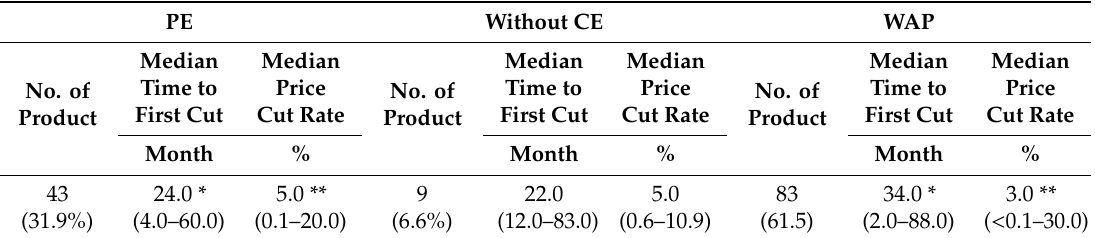
Table 2. Time elapsed until the first price cut after listing and its rate by review pathway.